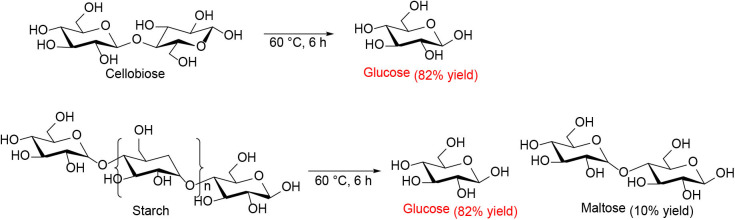
Transformation of cellobiose and starch in concentrated H5BW12O40 aqueous solutions (0.70 mol/L, 2 mL).